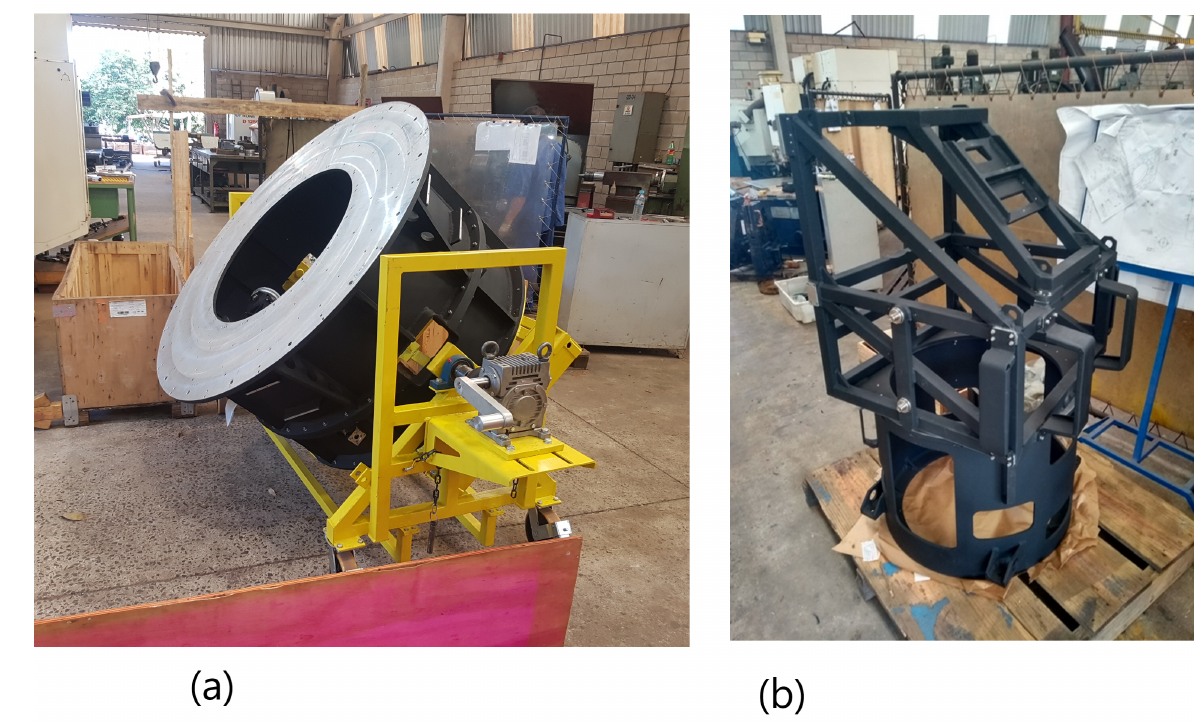
Figure 5. The NACOS system, in the Alfa factory at